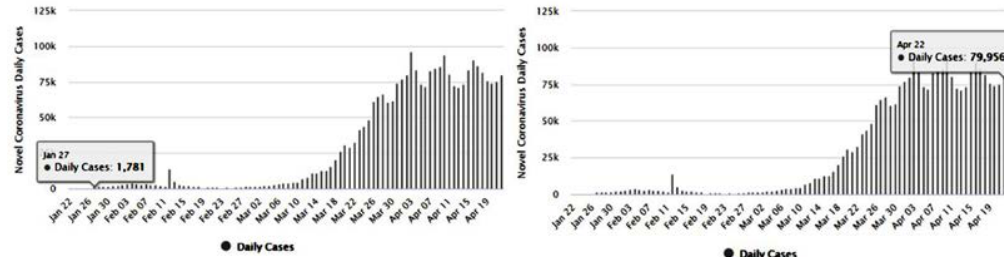
Fig. 4. Numbers of daily reported cases at the beginning of the year till the date Source: [16]